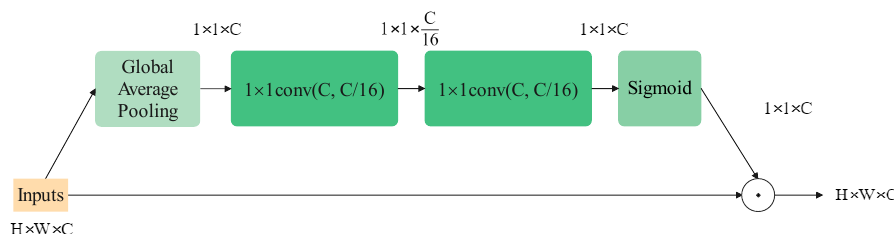
Figure 7. The modified SEBlock structure used in the proposed model.